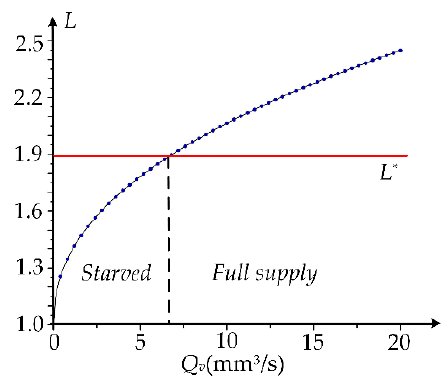
Figure 5. The trend of the dimensionless inlet distance at different oil flow rates.